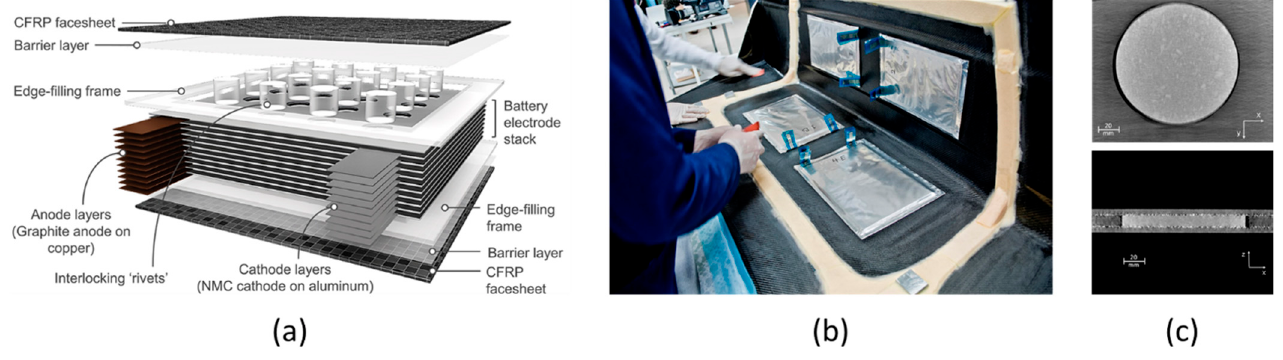
Figure 11. Sandwich-like composite material with a core battery cell [43] ( a ), rectangular-shaped supercapacitor cells introduced into a large L-angle composite specimen [79] ( b ), and a supercapacitor LATP pellet of cylindrical shape introduced into a flat composite panel (adapted from [7]) ( c